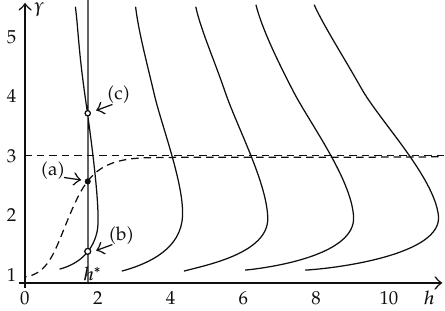
Figure 4: Plot of γ (cid:3) h (cid:4) . The first few dispersion curves are shown. Solid curves for the nonlinear case (cid:3) solutions of (cid:3) 7.14 (cid:4)(cid:4) ; dashed curve for the linear case (cid:3) solutions of (cid:3) 8.5 (cid:4)(cid:4) . The following parameters are used for both cases: ε 1 (cid:7) 1, ε 2 (cid:7) − 1 . 5, ε 3 (cid:7) 1, and for the nonlinear case a (cid:7) 5 . 2 and E are described by formulas: h ∗ (cid:7) 1 . 71 (cid:3) thickness of the layer (cid:4) , γ (cid:7) 1 (cid:3) lower bound for γ (cid:4) and γ (cid:7) 3 (cid:3) upper bound for γ in the case of linear medium in the layer (cid:4)